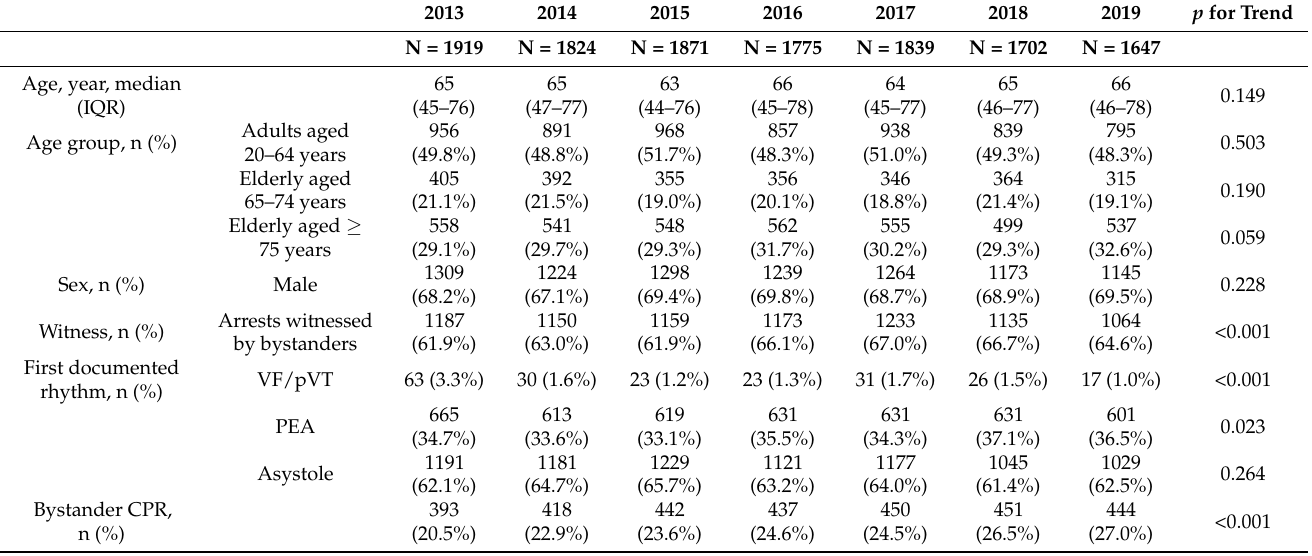
Table 1. Characteristics of patients and EMS involved in traumatic out-of-hospital cardiac arrests after traffic collisions.